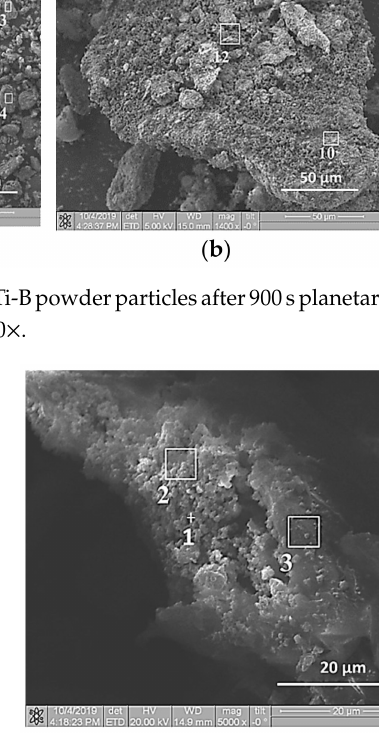
Figure 3. SEM image of Al-Ti-B composite